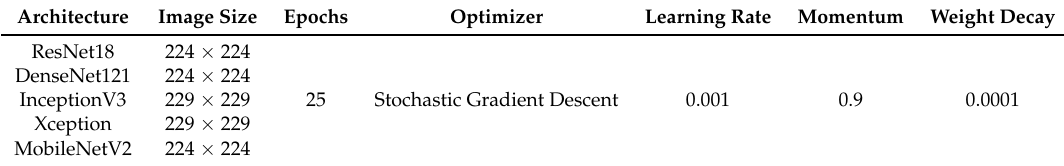
Table 3. Hyper-parameters used while fine-tuning the deep learning